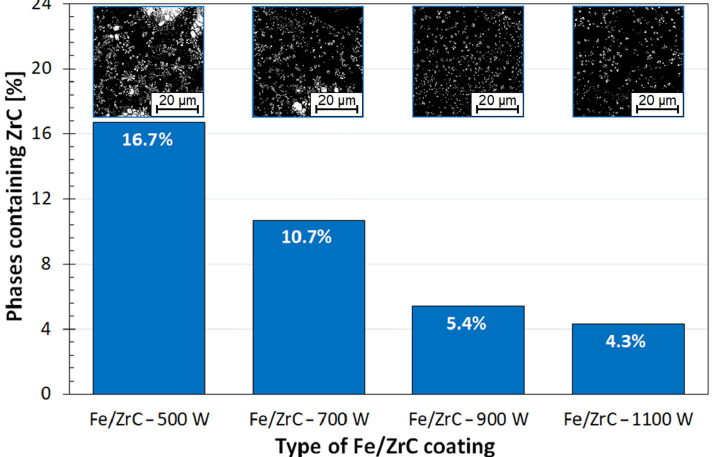
Figure 17. Graph of the content of the carbide phase in the Fe-based matrix—the figures above the bars show the carbide phase (white color) and the matrix (black color) for the area in the center of the remelted zone .